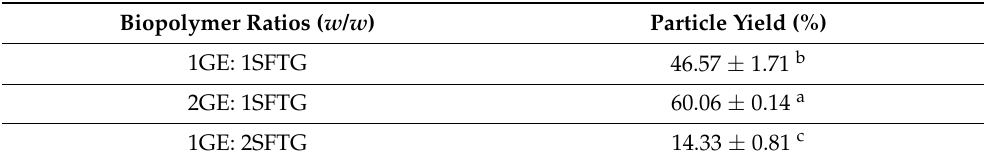
Table 1. Different formulations of complex coacervates between gelatin (GE) and soluble faction of tragacanth gum